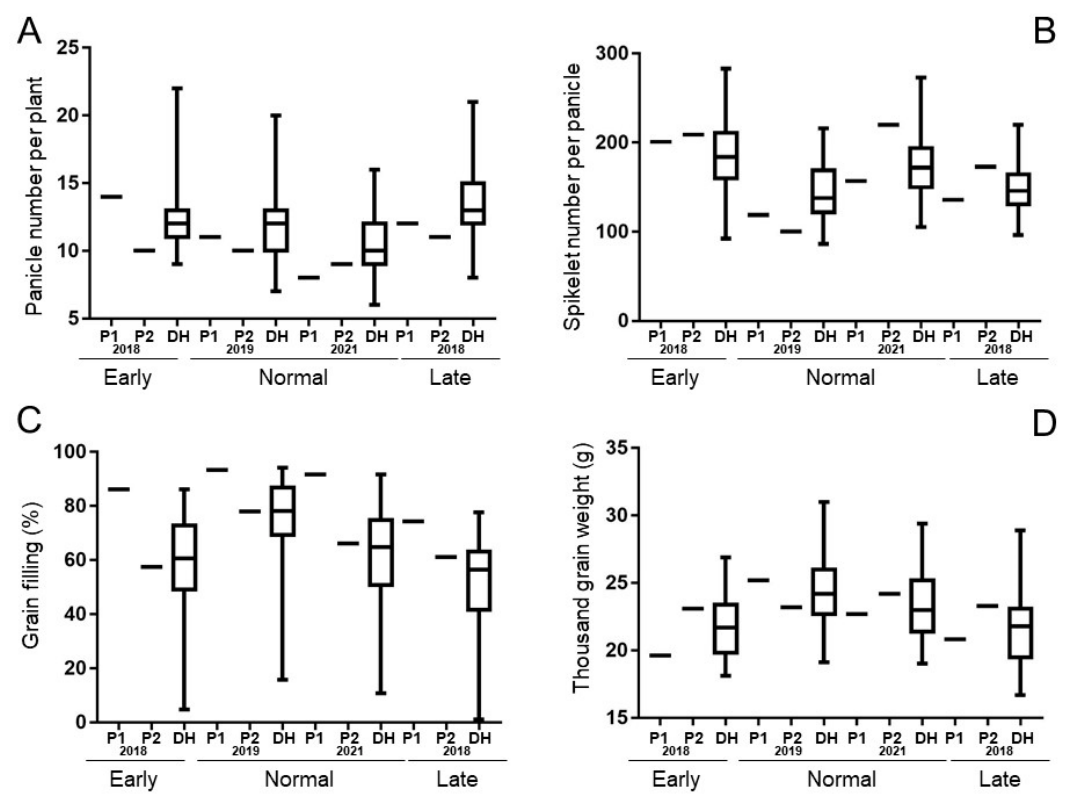
Figure 1. Phenotypic distribution of DH population of traits in different cropping seasons (P1: 93-11, P2: Milyang352). Phenotypes of normal season of 2021 had different distribution with normal season of 2019 except grain filling ratio. ( A ) Panicle number per plant; ( B ) Spikelet number per panicle; ( C ) Grain filling; ( D ) Thousand grain weight. Table 2. Grain properties of the mapping population in different cultivation seasons. a, b, ab, c: Similarity based on T -test result (a: similar with 93-11, b: similar with Milyang352, ab: no difference with both parental lines, c: different with both parental